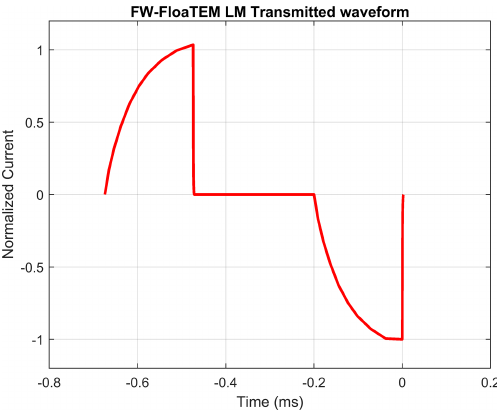
Figure A3. LM current waveform for the FW-FloaTEM system.